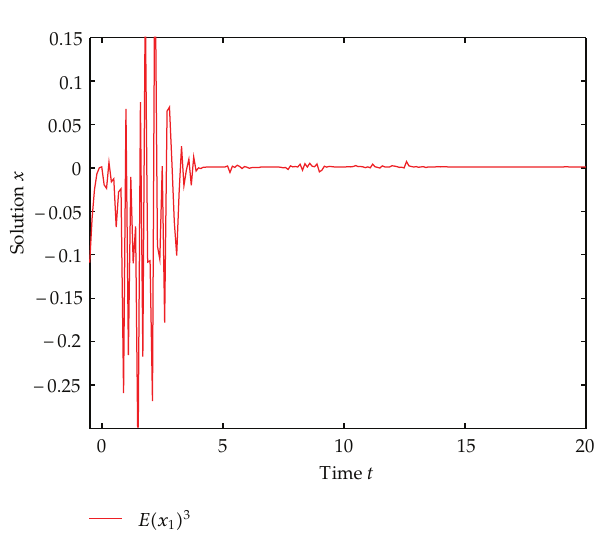
Figure 1: Numerical solution E (cid:6) x 3